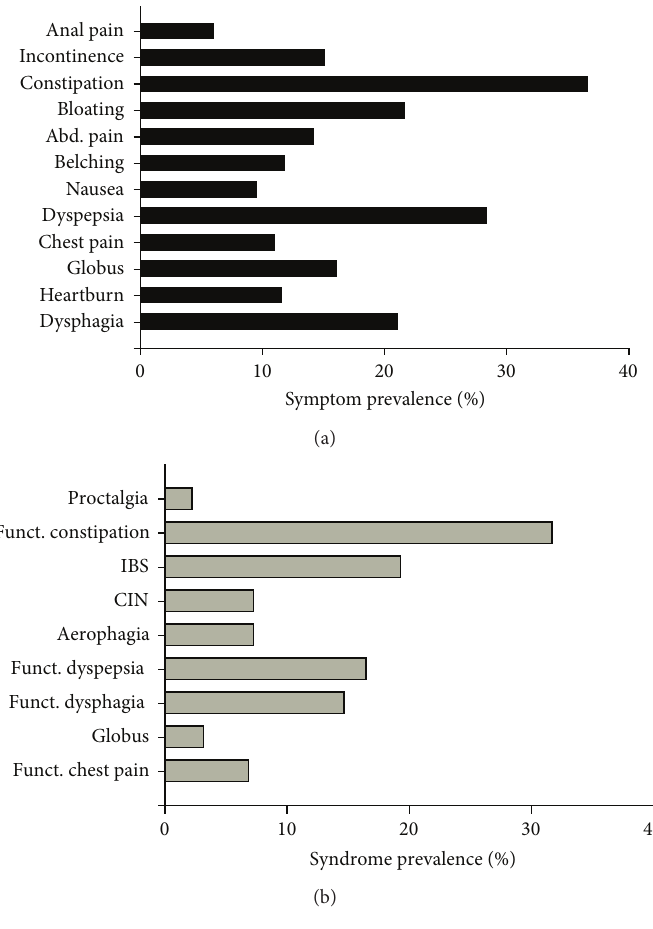
Figure 1: Prevalence of gastrointestinal symptoms (a) or defined syndromes based on Rome III criteria (b) in MS patients ( 𝑛 = 218 ). Only symptoms and syndromes with a prevalence of at least 3% were included in the graph. CIN: chronic idiopathic nausea; IBS: irritable bowel